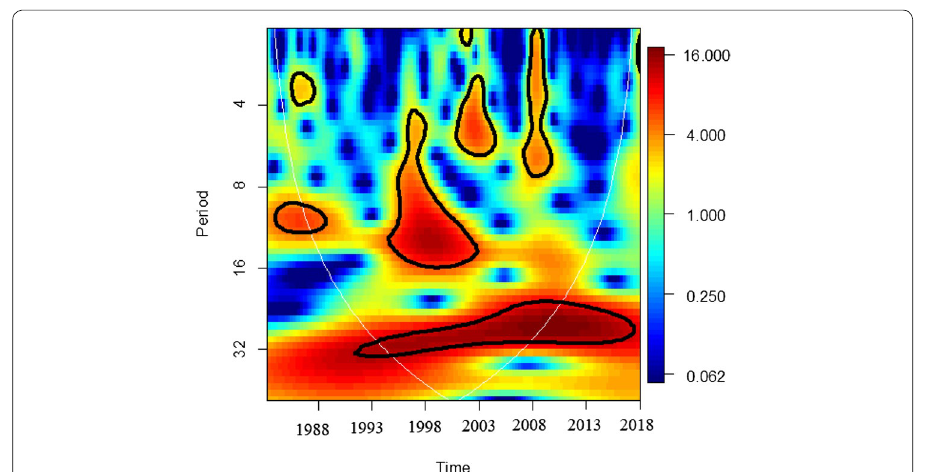
Fig. 2 Wavelet power spectrum for ERI